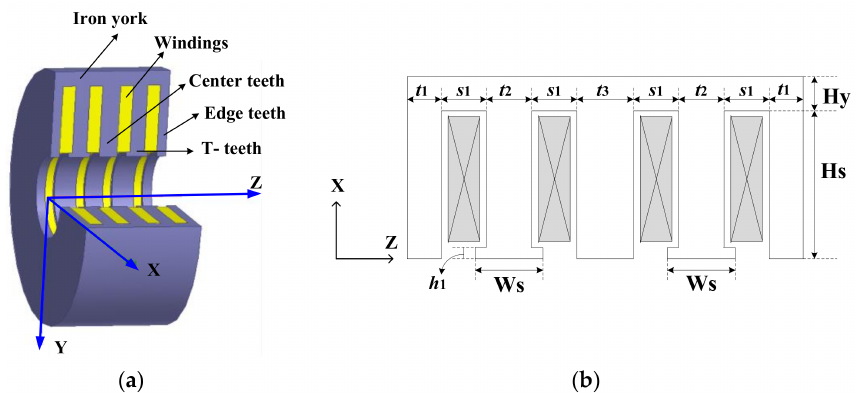
Figure 4. Stator structure of the TPMLG: ( a ) three-dimensional structure and ( b ) main parameters.